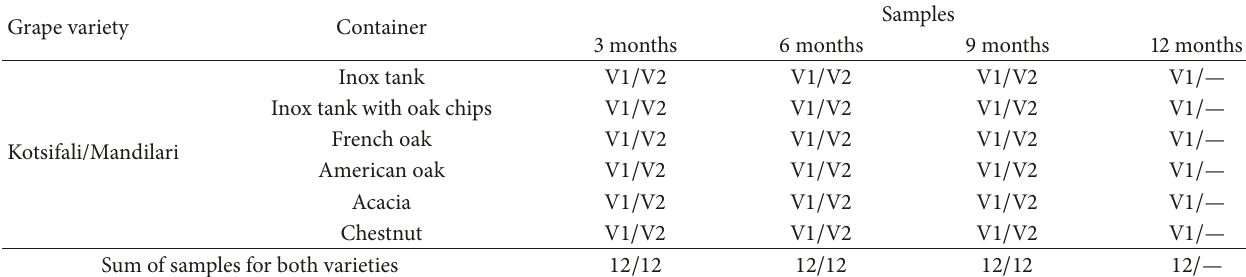
Table 1: Samples and containers per vintage (V1: 2012; V2: